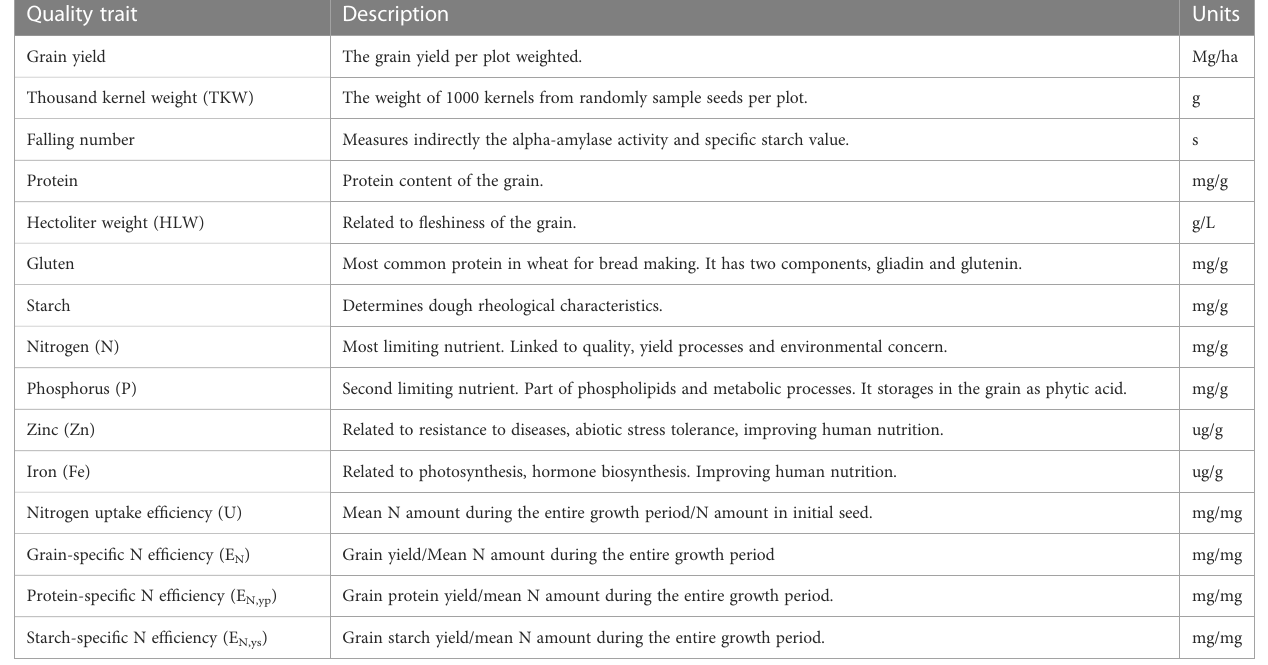
TABLE 2 Description and units of 15 traits measured in this study. Quality trait